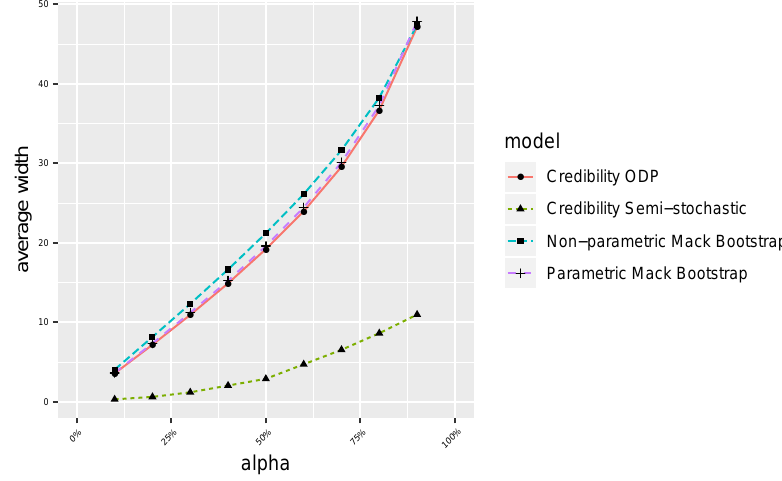
Figure A1. Average width values from the log-normal data.